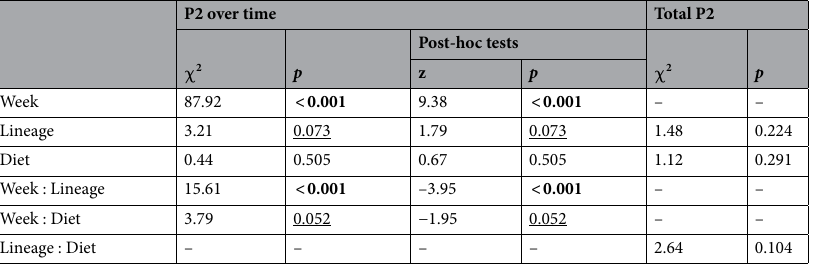
Table 2. Statistical results for GLME analysis of focal male paternity (P2) over time (n = 440 mother-week combination) and in total (n = 69 families) when female was mated with male from same population at first and after with focal male. Values in bold represent significant effects and nearly significant effects are underlined.